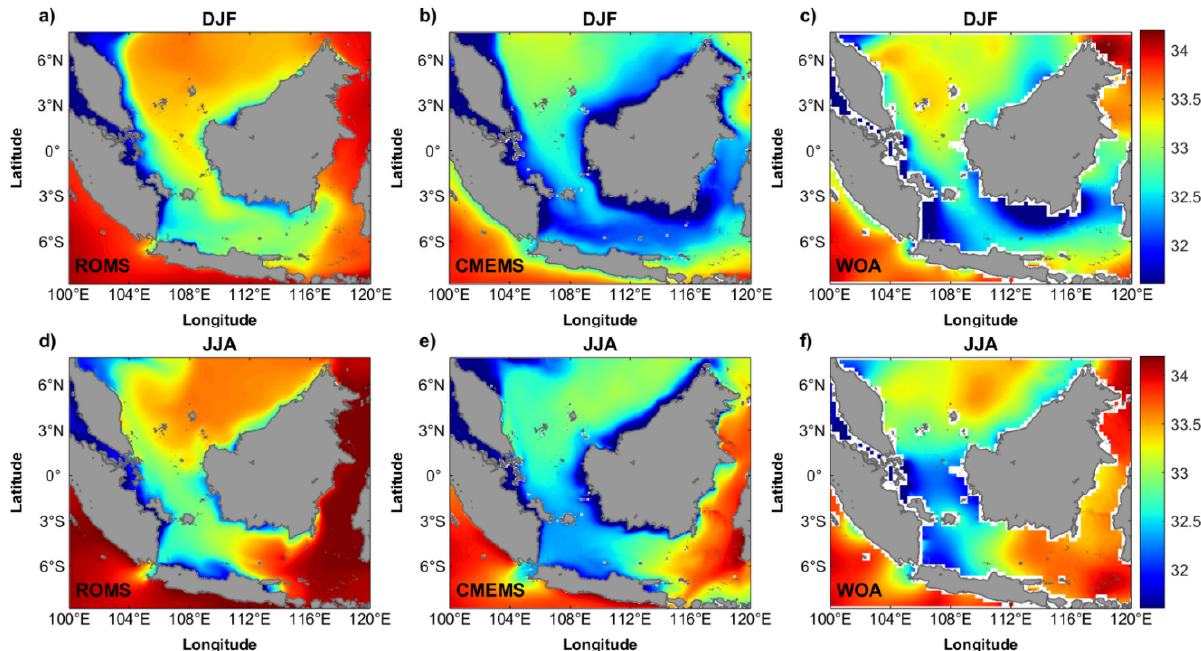
Figure 6. Seasonal SSS (unit: psu) climatology during the boreal winter ( a – c ) and boreal summer ( d – f ) derived from ROMS ( left panel), CMEMS ( middle panel), and WOA ( right panel).